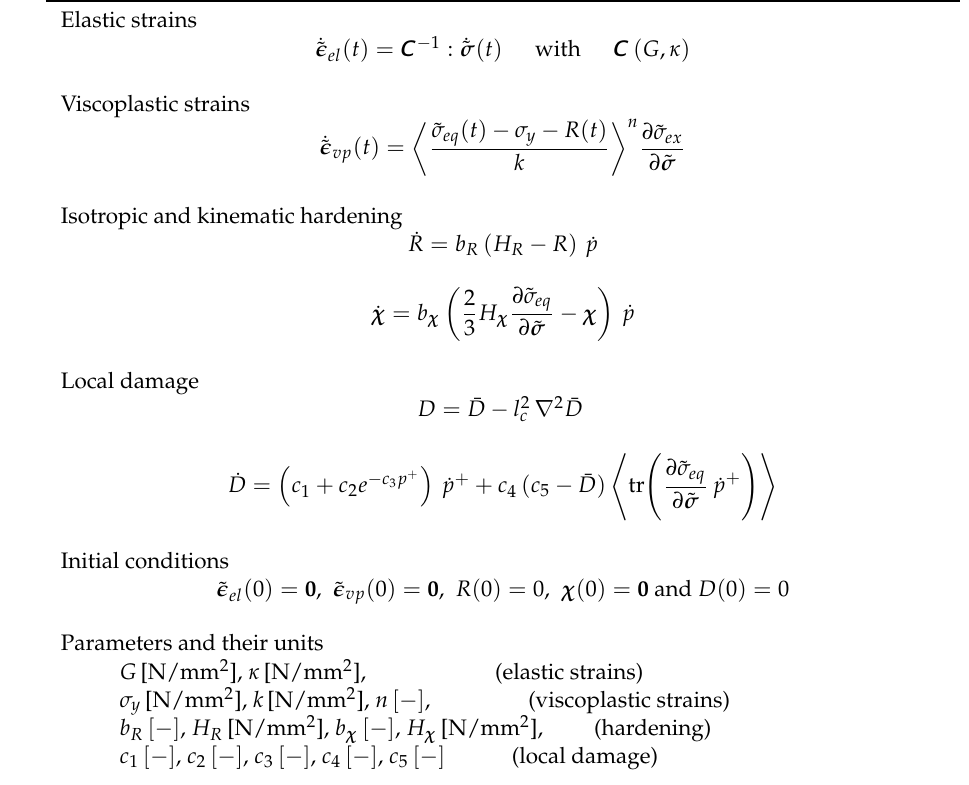
Table 1. Chaboche-type material with hardening and